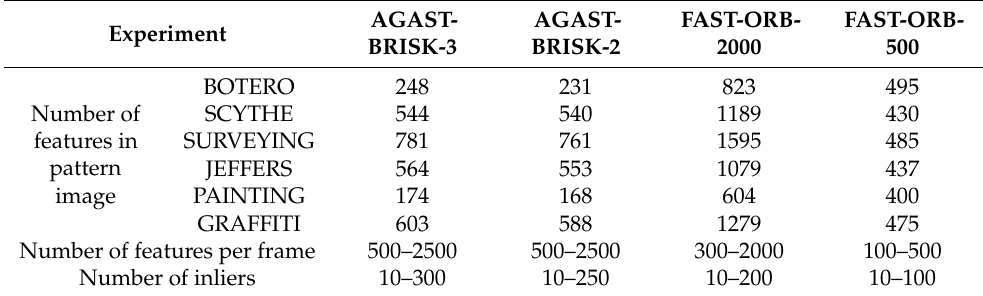
Table 6. Number of features extracted in each pattern image, number of features per frame and number of inliers for the experiments performed using the ModAR prototype.